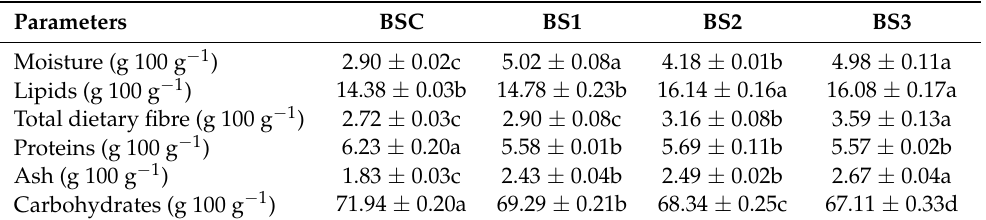
Table 2. Mean values, standard deviation, and results of statistical analysis of the proximate composi- tion of GF